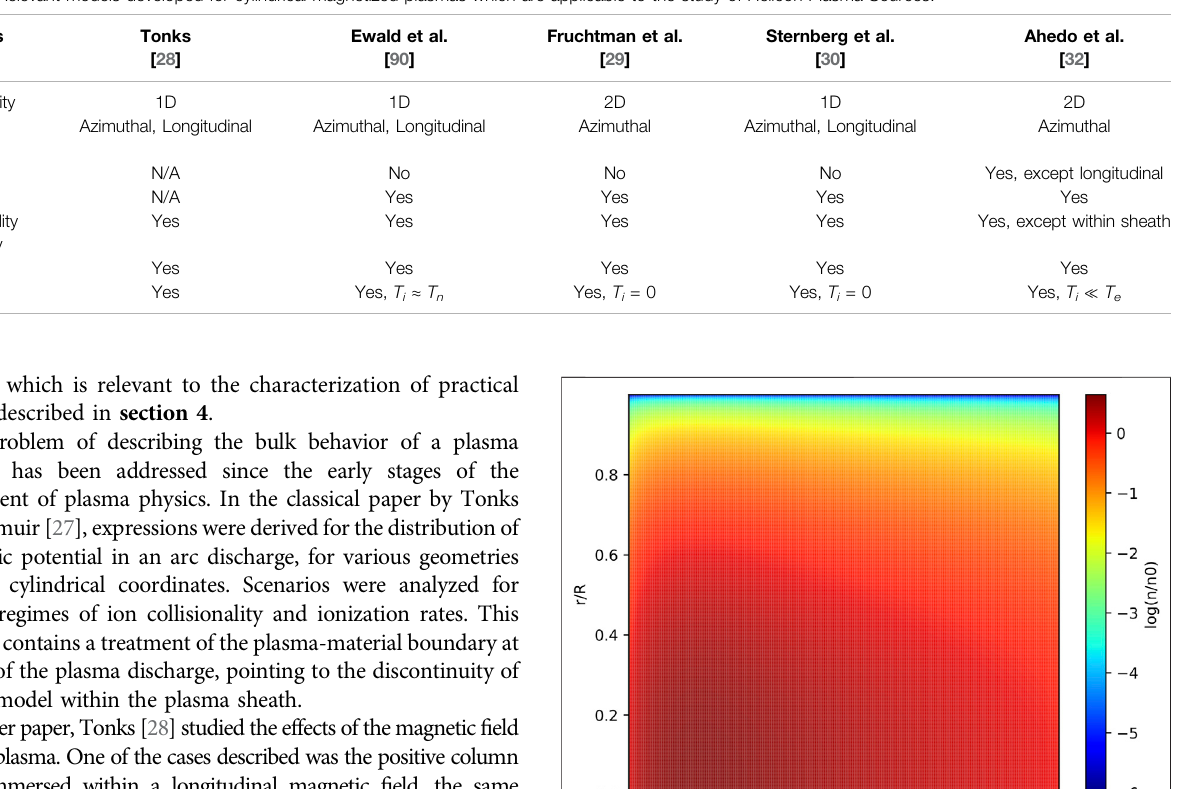
TABLE 1 | Relevant models developed for cylindrical magnetized plasmas which are applicable to the study of Helicon Plasma Sources.